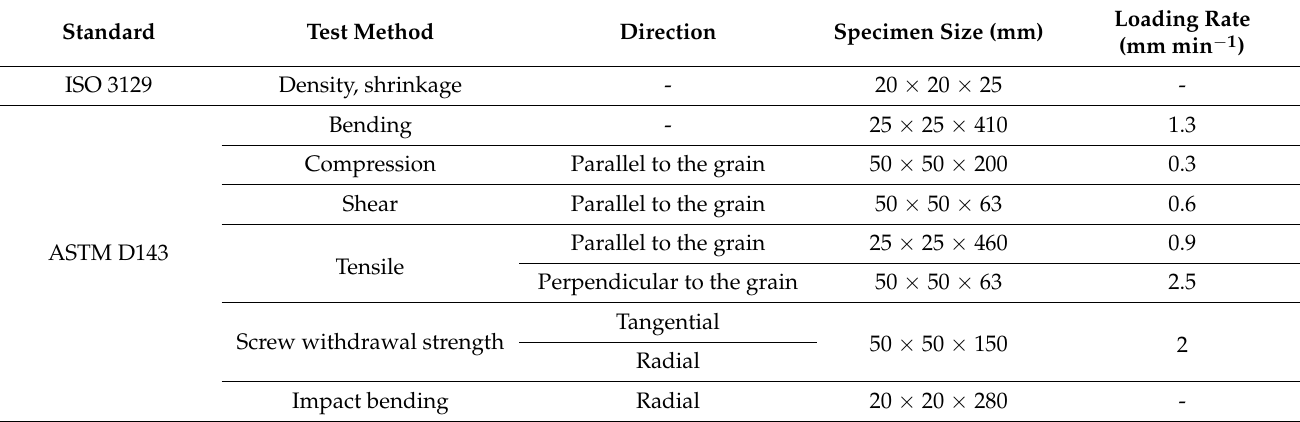
Table 2. Experimental test methods and characteristics of the studied wood